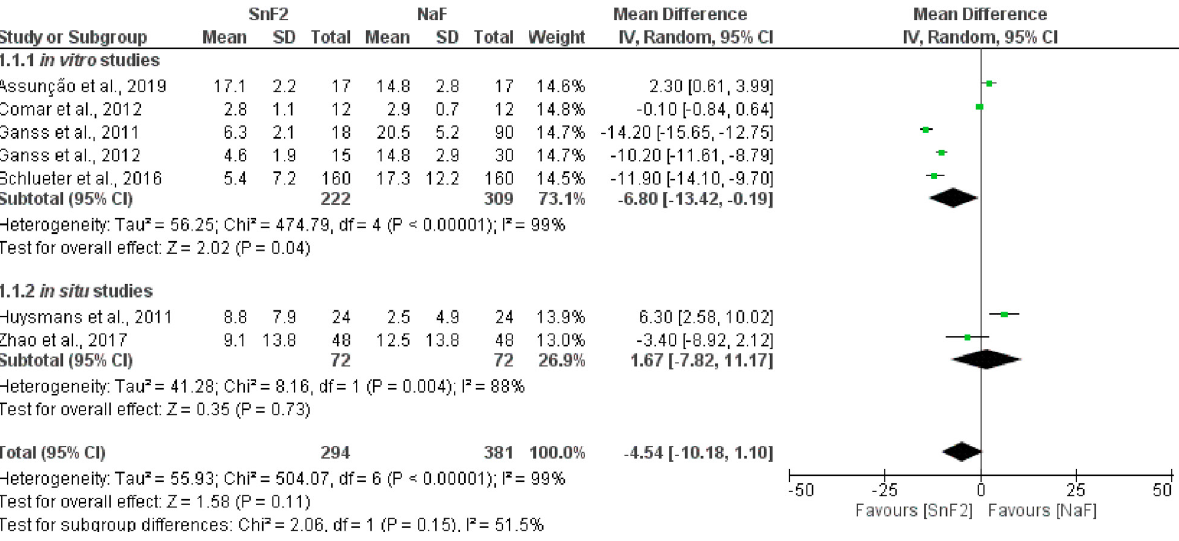
Figure 2. Summary findings of the meta-analyses comparing the use of SnF